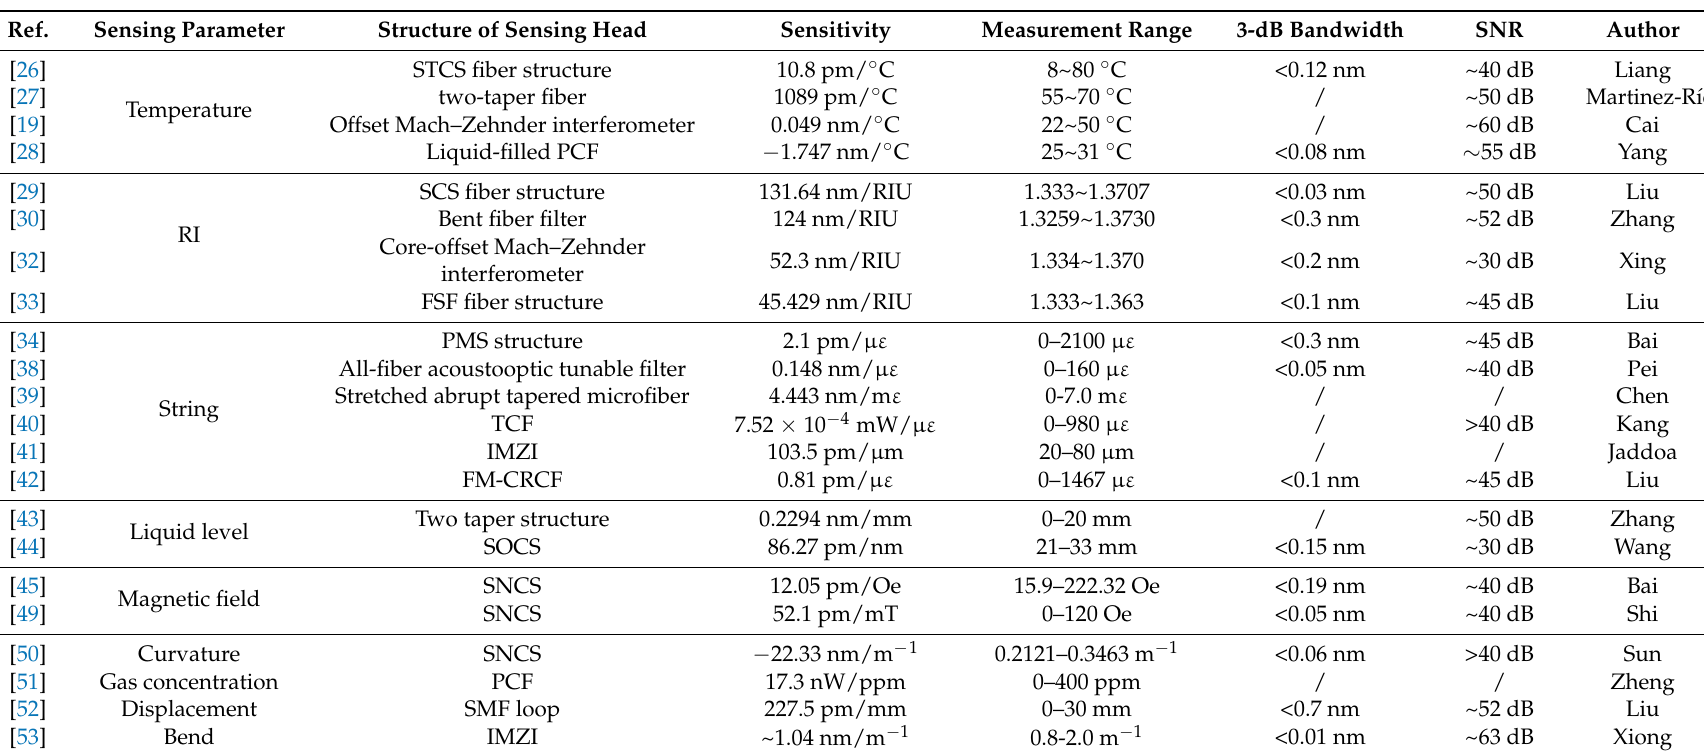
Table 1. Mach–Zehnder Interferometer typed